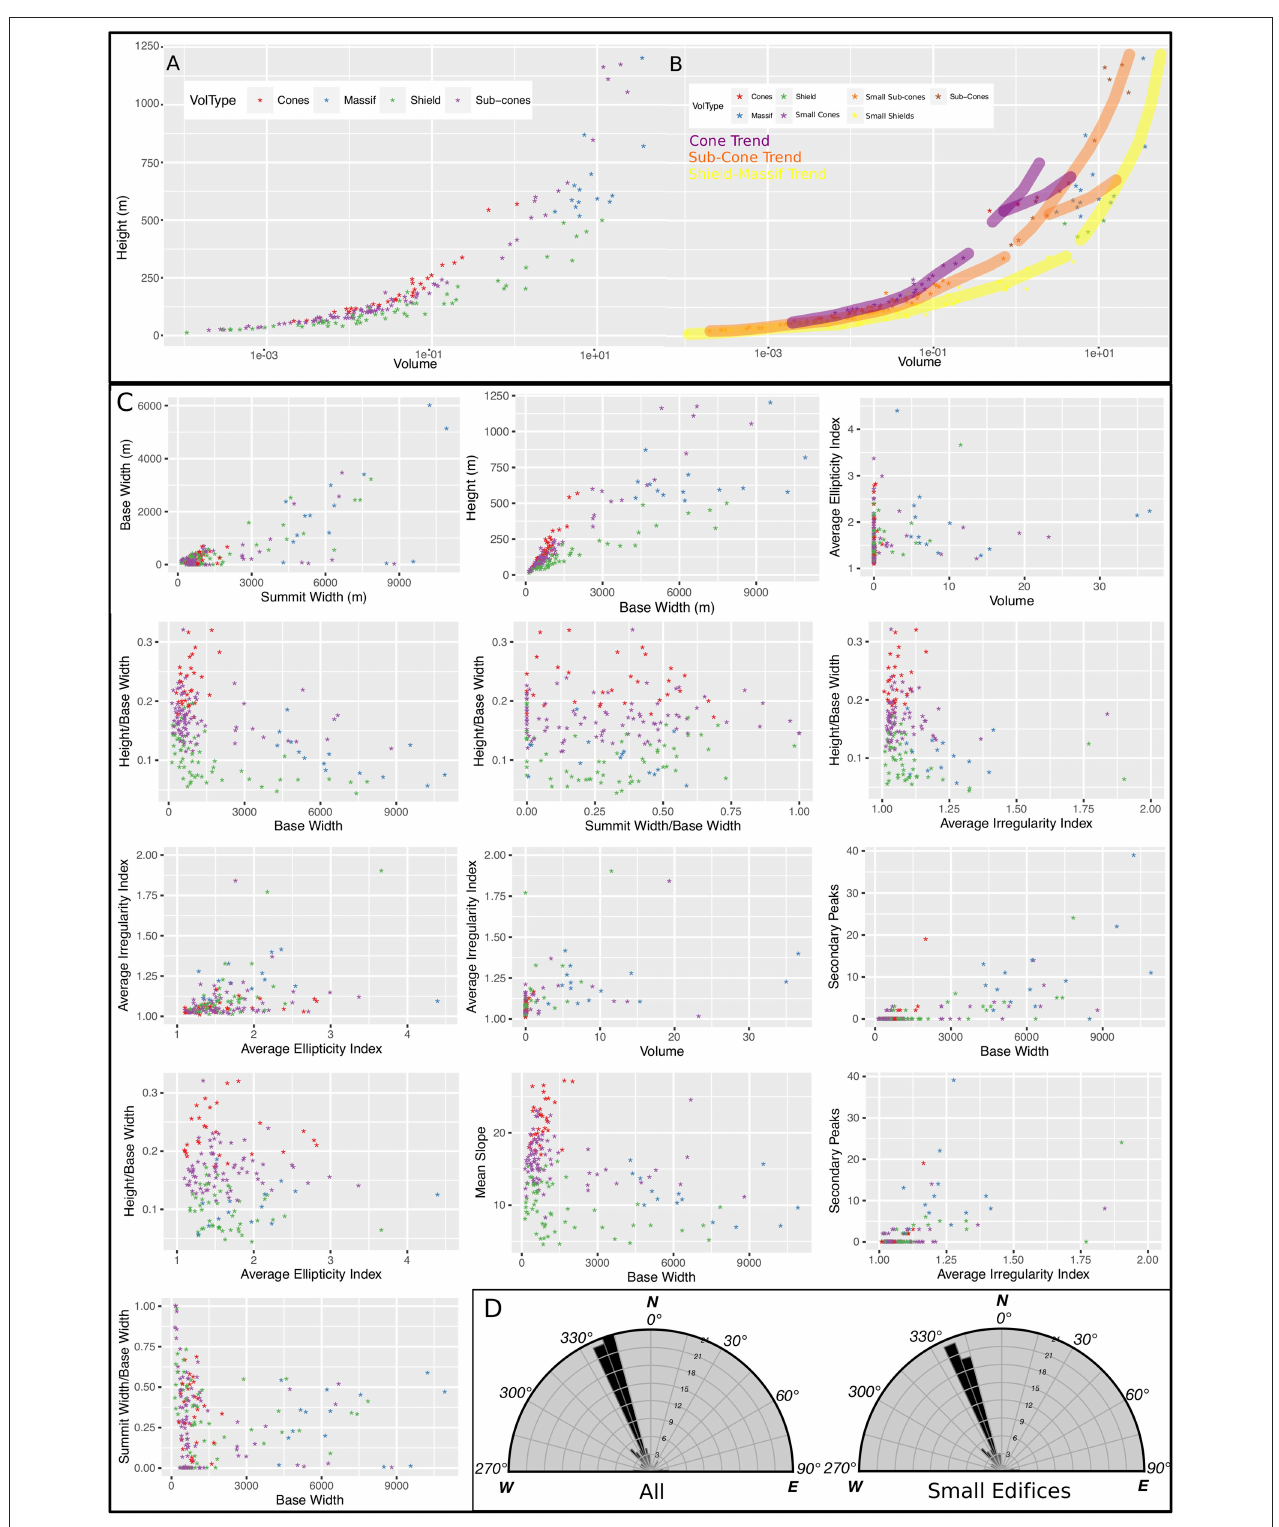
FIGURE 5 | Volcano morphometry. (A) Volume vs. height plots for all volcanoes grouped by morphological classification: cones, sub-cones, shields, and massifs based on their height and basal width ratio; (B) A second morphological classification based on height separating bigger and smaller edifices on a volume vs. height plot to draw a volcano evolutionary trend; (C) X-Y plots of selected morphometric parameters grouped by morphological type (cones, sub-cones, shields and massifs); and (D) A rose diagram showing the preferred direction of alignments that can be formed by at least 3 volcano centroids within 6km. Dataset available in Supplementary